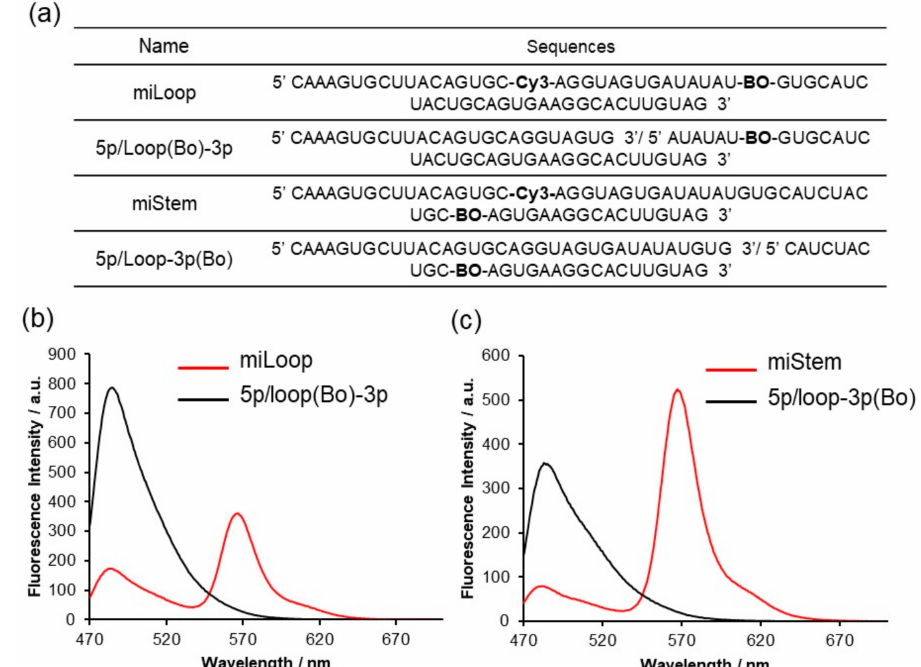
Figure 3. Fluorescent emission spectra of pre-miR17 incorporating the FRET dyes. ( a ) Sequence of each RNAs. Fluorescent emission spectra of miLoop ( b ) and miStem ( c ) recorded at an excitation of 458 nm at 20 ◦ C. The solution conditions are as follows: a 10 mM phosphate buffer, 100 mM NaCl, pH 7.0, 1.0 µ M RNA. The fluorescence intensities are presented in a.u.